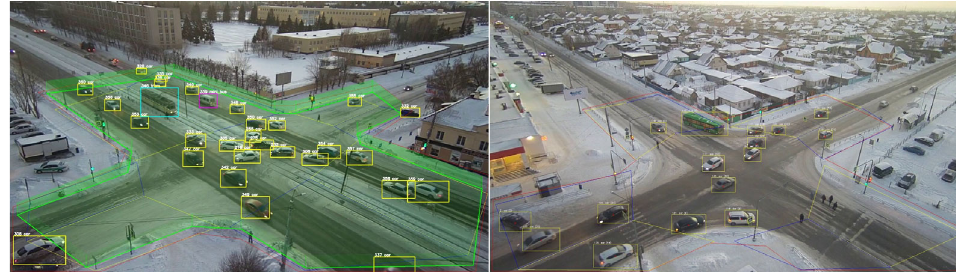
Figure 2. Collection of data on traffic flow parameters using the YOLOv4 neural network. Collecting data from street cameras makes it possible to track the movement and individual dynamic parameters of vehicles over a long period and across large sections of the road network. This approach requires significantly fewer sensors and less server power while greatly improving the accuracy of vehicle-related emissions